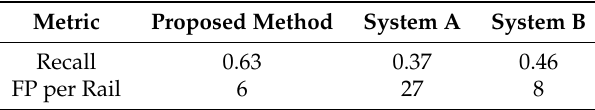
Table 2. Result comparison in the knowledge